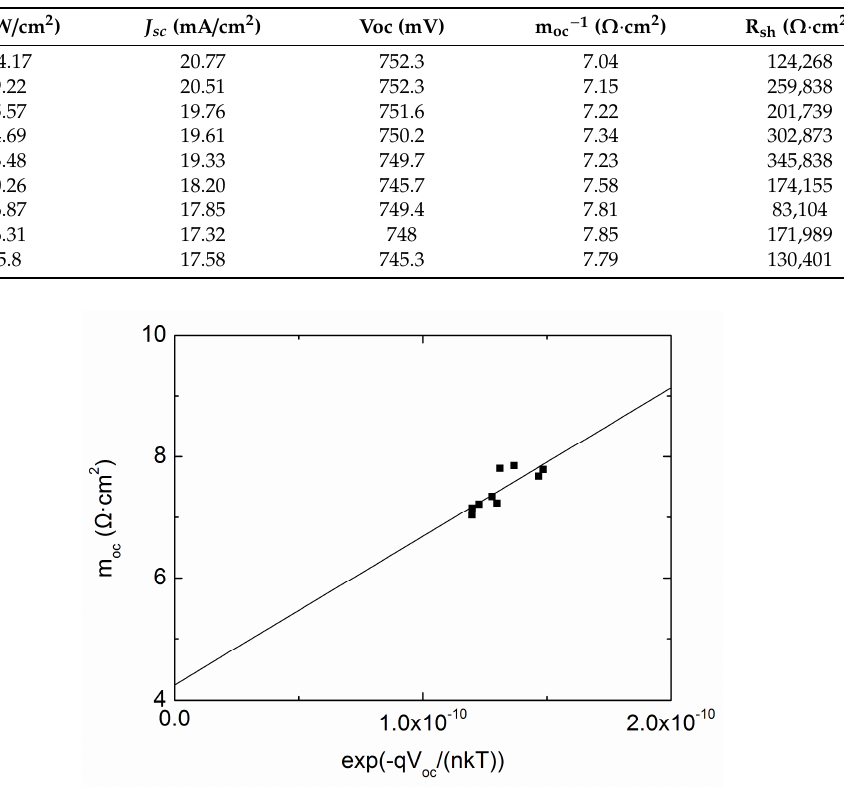
Figure 3. m oc − 1 versus exp( − qV OC / ( nkT )) for extraction of R s for cell #1.